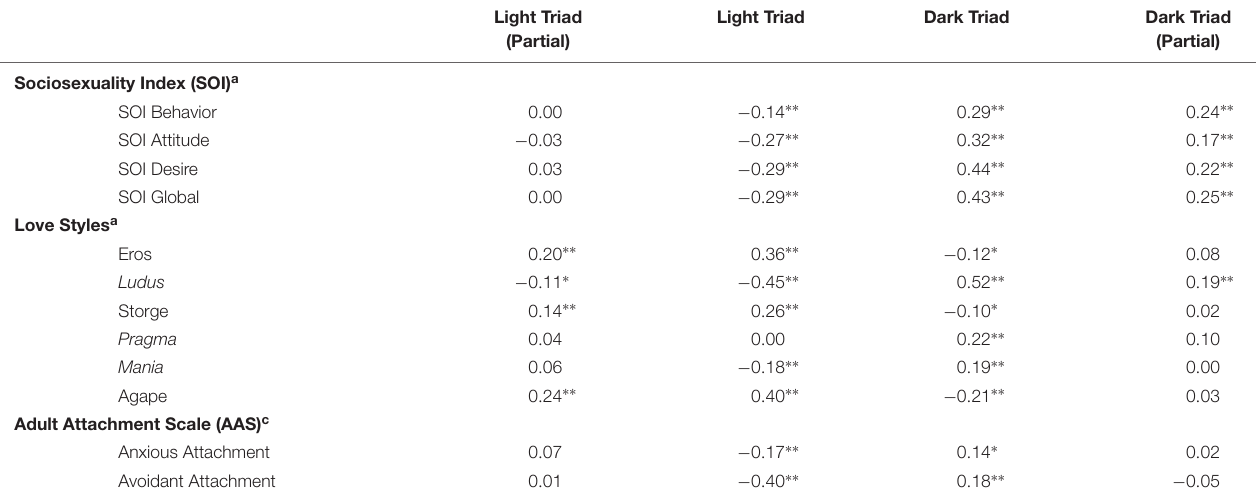
Light Triad Light Triad Dark Triad Dark Triad (Partial)